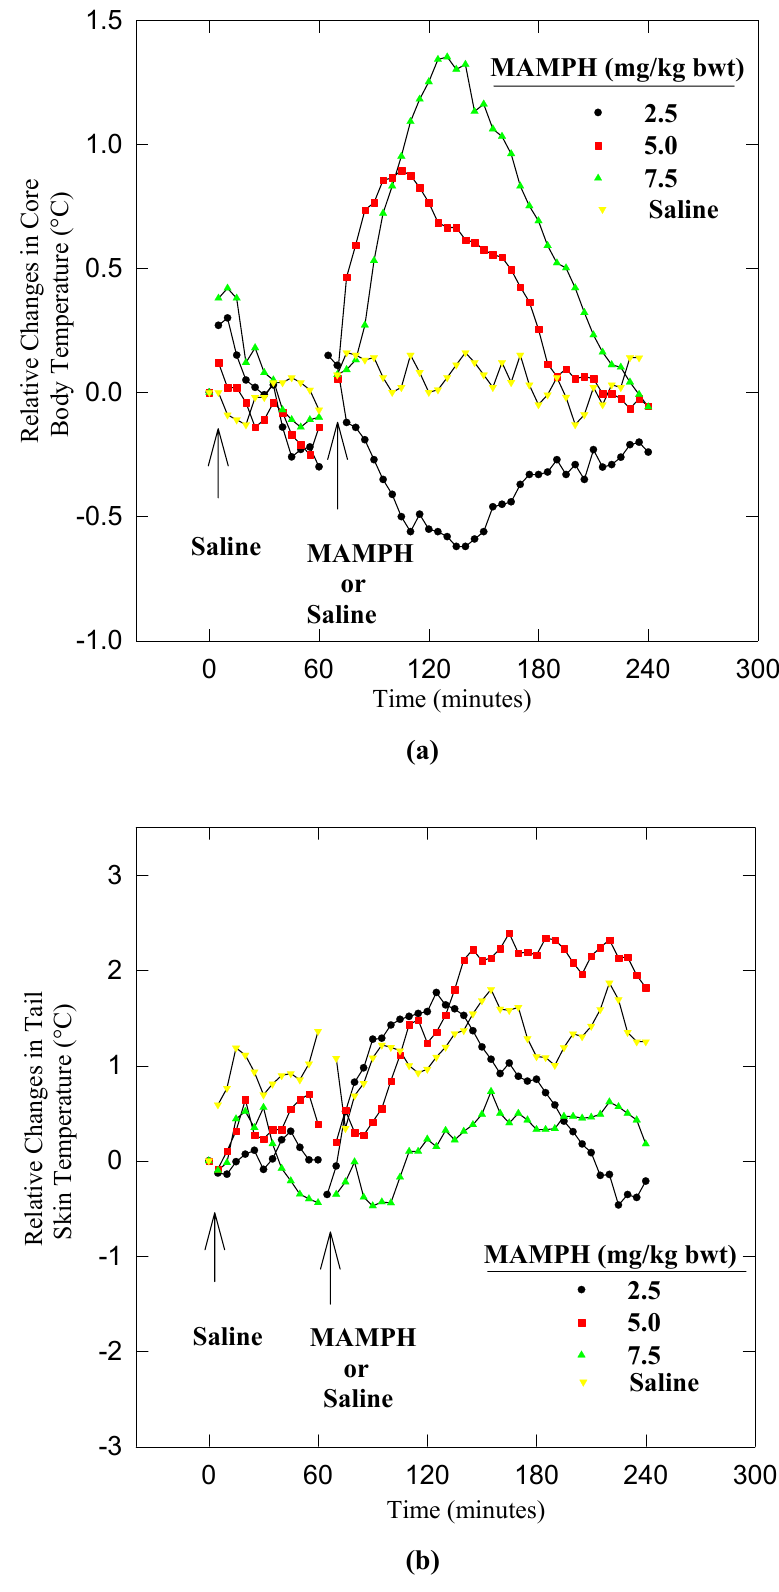
Figure 1. Effects of methamphetamine on a) core body and b) tail skin temperature of male rat at 21 ±